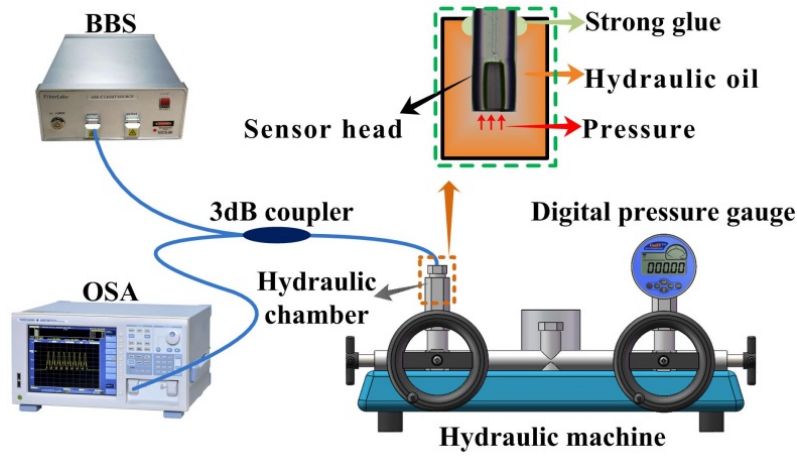
Figure 3. Hydraulic pressure test equipment.